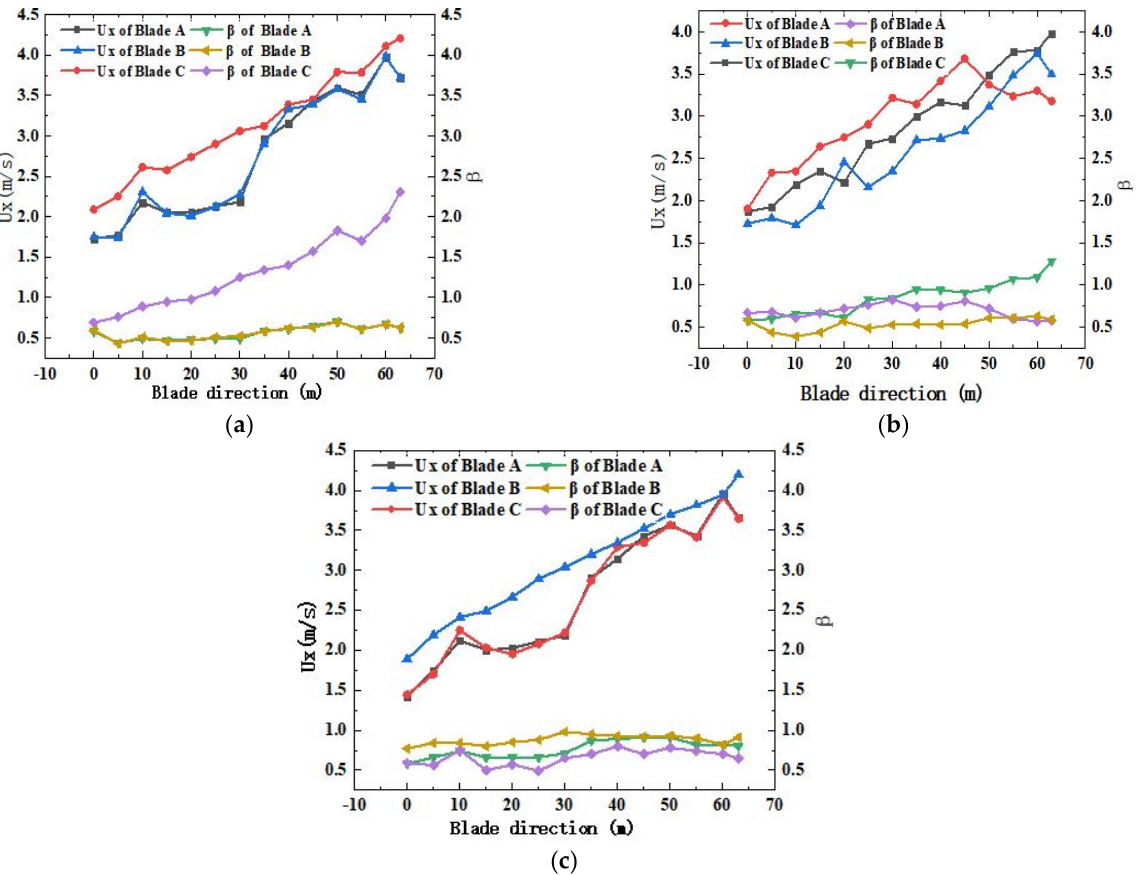
Figure 11. Final-velocity distribution of rain on the blade; ( a ) 0°; ( b ) 30°; ( c ) 60°.